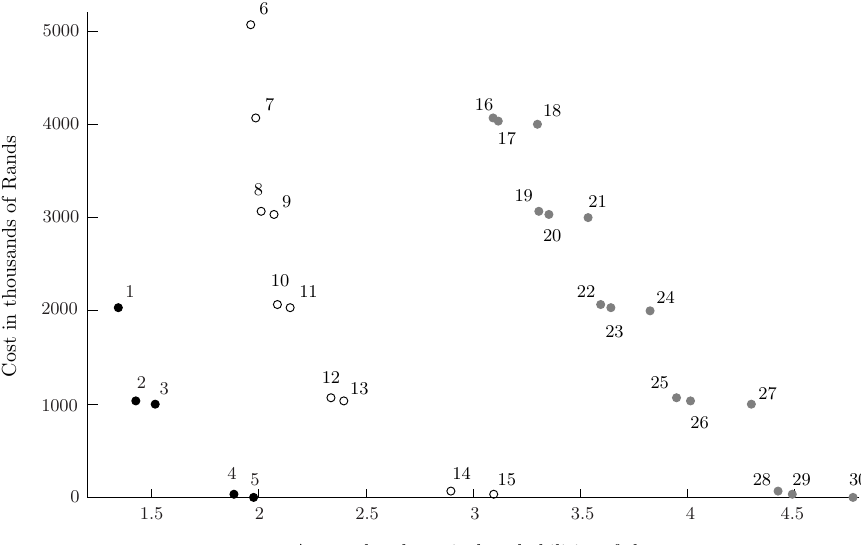
Figure 4: Graphical illustration of the sets of approximately Pareto optimal solutions obtained by means of the NSGA II for stages t 16–30) of the scenario in